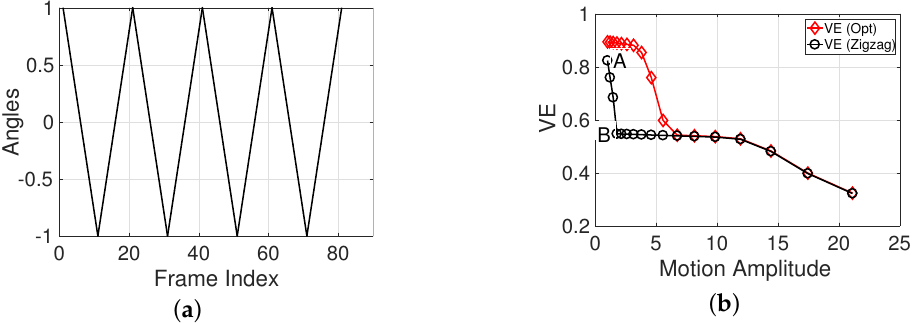
Figure 9. Viewing Experience ( VE ) scores based on pure motions. ( a ) Example of pure motion; ( b ) VE